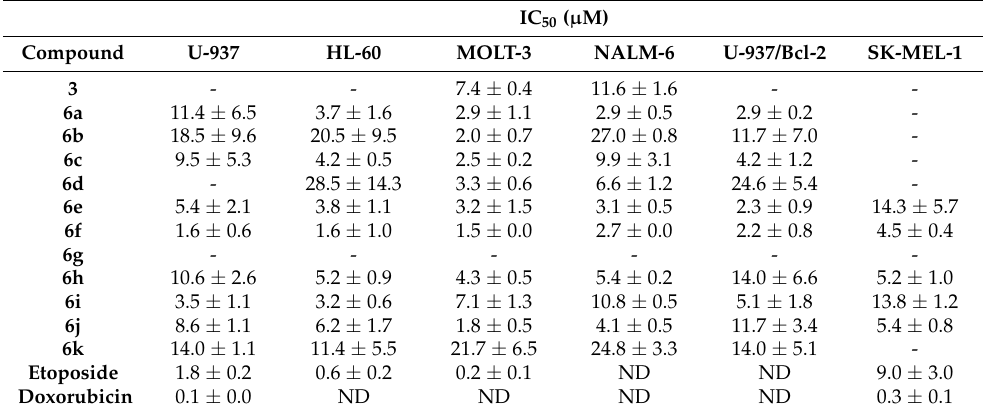
Table 2. Effects on cell viability of hybrid compounds on human cancer